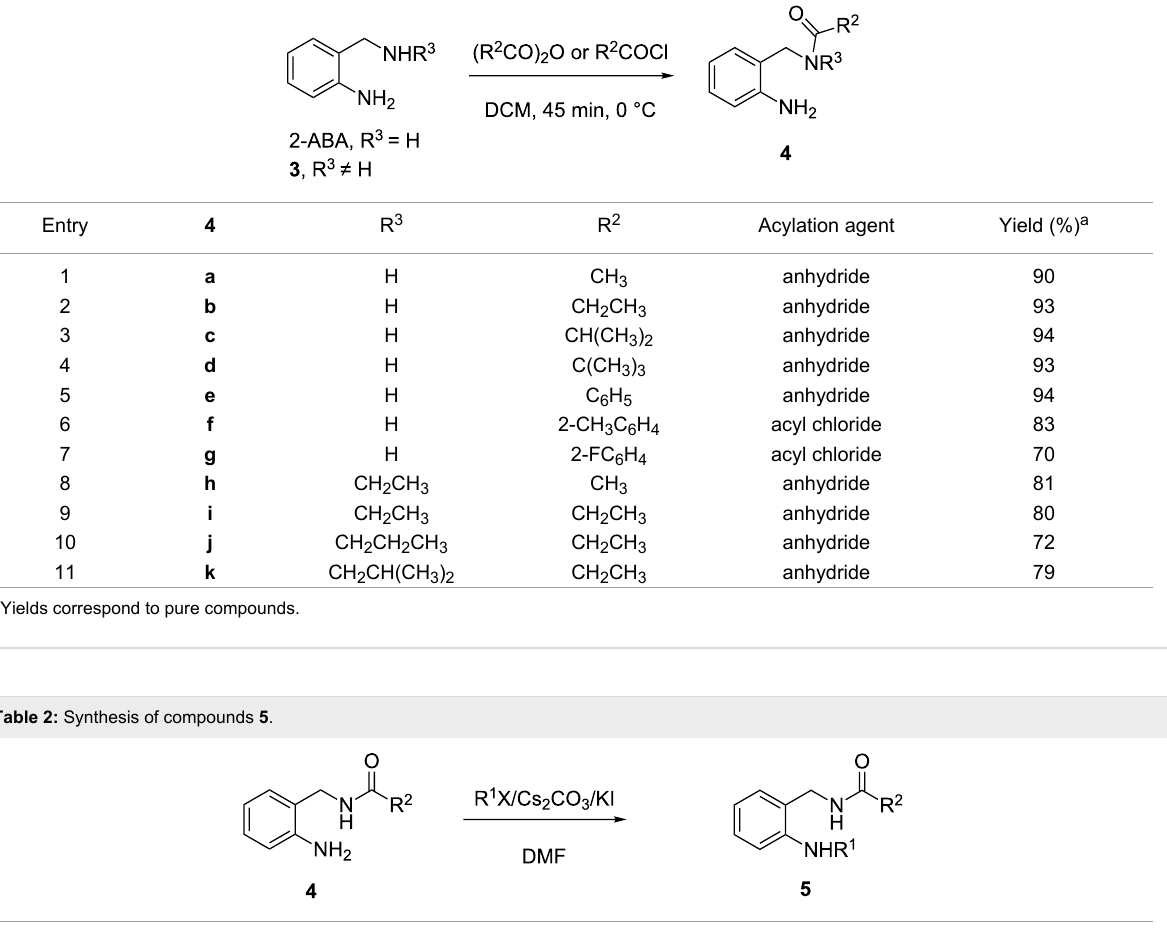
Table 1: Selective N -acylation of 2-ABA and its derivatives.